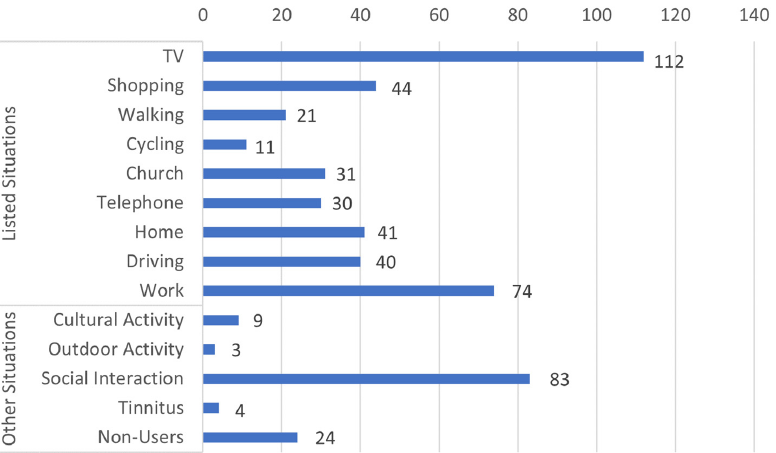
Figure 2. Situations where HA users always put on their HAs. The numbers beside the bar represent the number of participants responding to a speci fi c situation where they always put on their HAs.